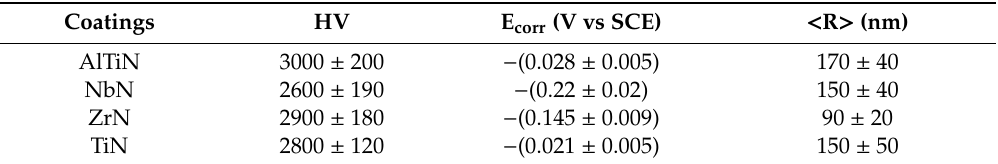
Table 1. Average values of hardness (HV), corrosion potential in Na 2 SO 4 (pH 5.5) and roughness ( < R > ) values for each studied physical vapor deposition (PVD)